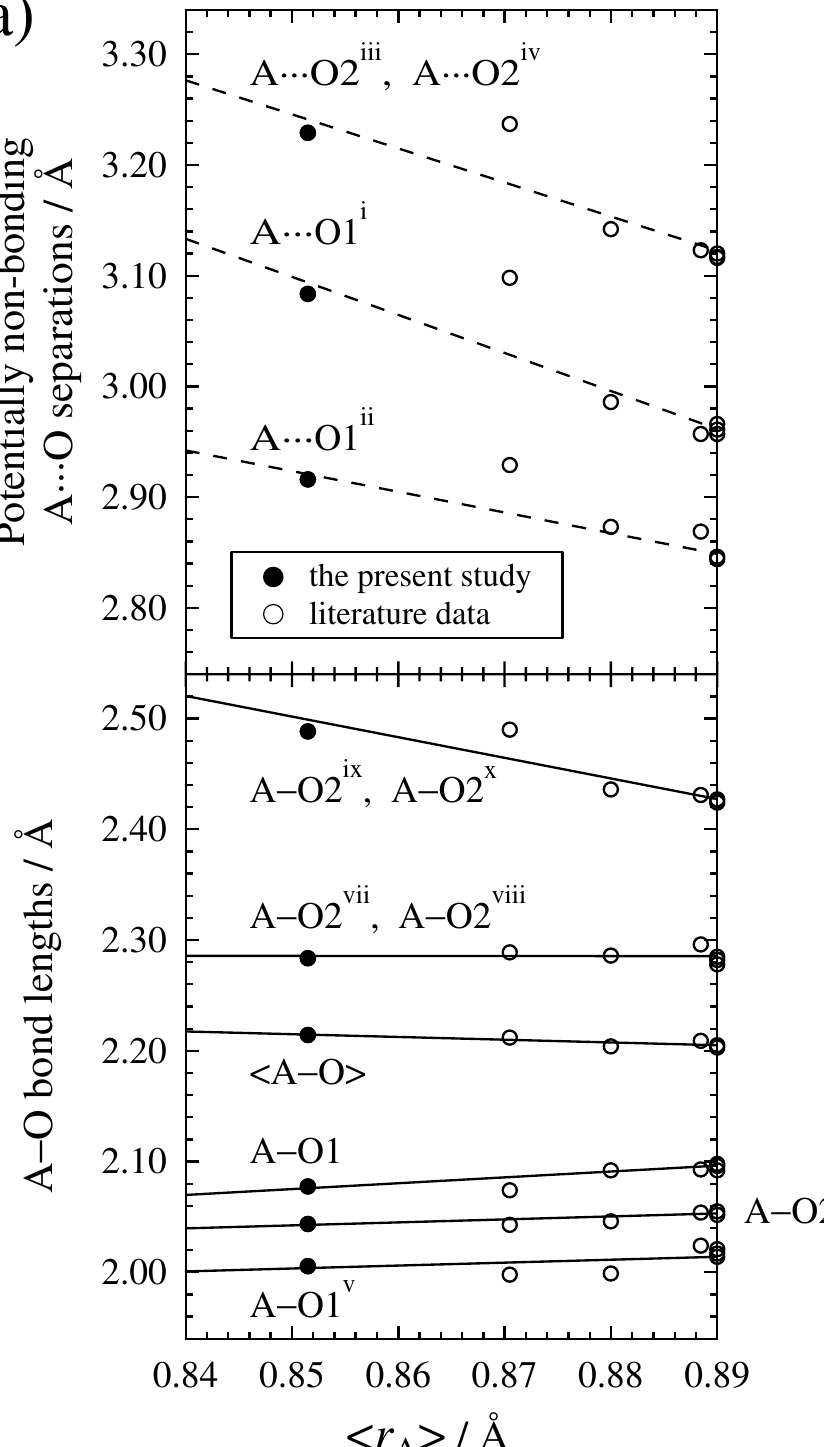
Figure 4. ( a ) A–O bond lengths and potentially non-bonding A ⋯ O separations as a function of the mean cation size on A site (< r A >), and ( b ) B–O bond lengths as a function of the mean cation size on B site (< r B >). The literature data from the single-crystal X-ray diffraction studies of the end-member MgSiO 3 bridgmanite 44–46 and the (Fe, Al)-bearing bridgmanites 3 are represented together with the present